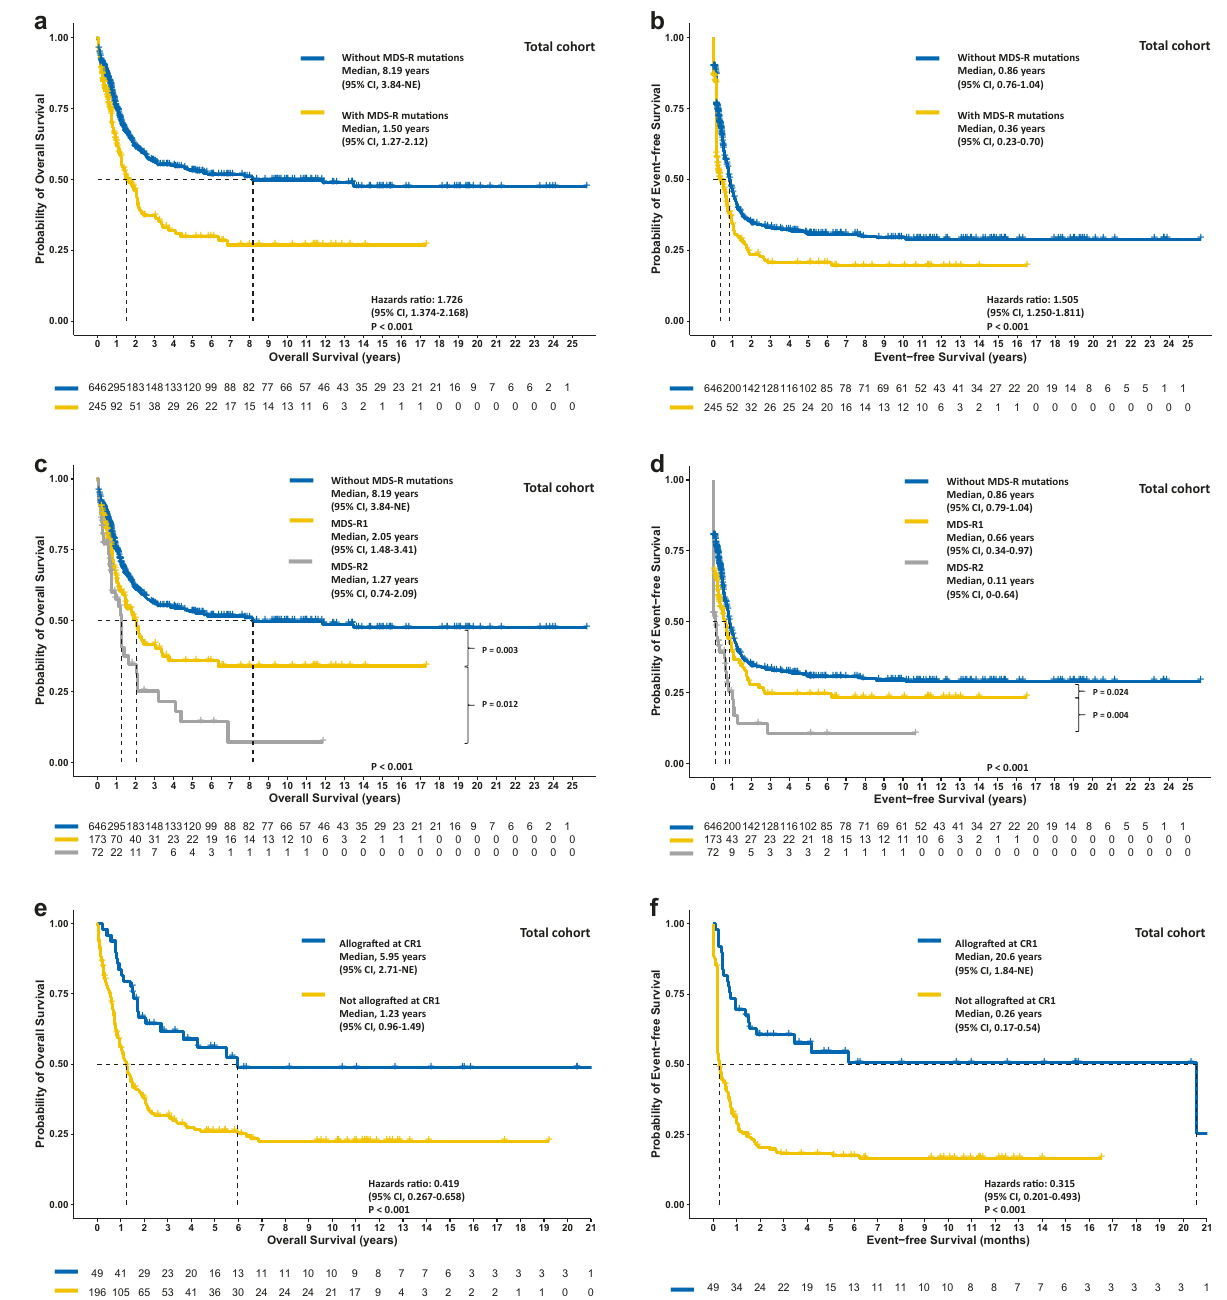
Fig. 2 The Kaplan ‒ Meier survival curves for the total cohort. OS ( a ) and EFS ( b ) strati fi ed by the status of MDS-R mutations, the MDS-R mutation burdens ( c and d , respectively), and treatment with or without allogeneic transplantation at fi rst remission ( e and f , respectively). Allogeneic transplantation may overcome the negative prognostic impact of MDS-R mutations. MDS-R1, with one MDS-R mutation; MDS-R2, with 2 or more MDS-R mutations. mutations at diagnosis, all patients with MRD after induction therapy and 88% of those with MRD after the 1st consolidation had at least one MDS-R mutation at morphological CR, indicating the leukemia clones with MDS-R mutations might be relatively chemoresistant. Among the patients with MDS-R at diagnosis, the presence of NGS MRD predicted a higher early relapse rate (1-year cumulative incidence of relapse, 51.5% vs . 23.6%, P < 0.001), consistent with the concept that persistent MRD is predictive of early relapse. Blood Cancer Journal (2023)